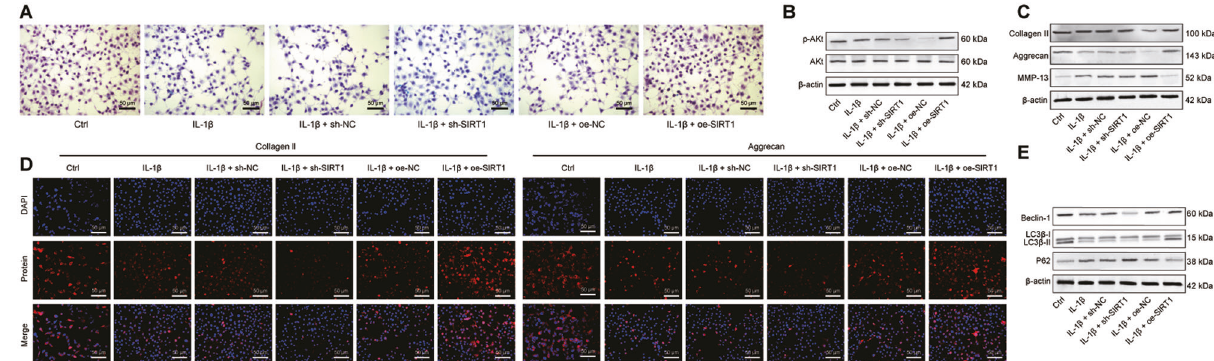
Fig. 5 SIRT1 affects chondrocyte synthesis, metabolic imbalance and autophagy in OA by upregulating EGFR via PTEN. A Safranin O staining to detect the deposition of GAGs in human chondrocytes in the presence of SIRT1 knockdown or restoration. B Western blot to detect p-Akt and Akt protein expression levels in human chondrocytes in the presence of SIRT1 knockdown or restoration. C Western blot for Collagen II, Aggrecan and MMP-13 in human chondrocytes in the presence of SIRT1 knockdown or restoration. D Immuno fl uorescence staining assay for Collagen II (green fl uorescence) and Aggrecan (red fl uorescence) after knockdown or restoration of SIRT1. E Western blot assay to detect the expression levels of Beclin-1, LC3B-I, LC3B-II and p62 proteins in human chondrocytes after knockdown or restoration of SIRT1. Cell experiments were performed in